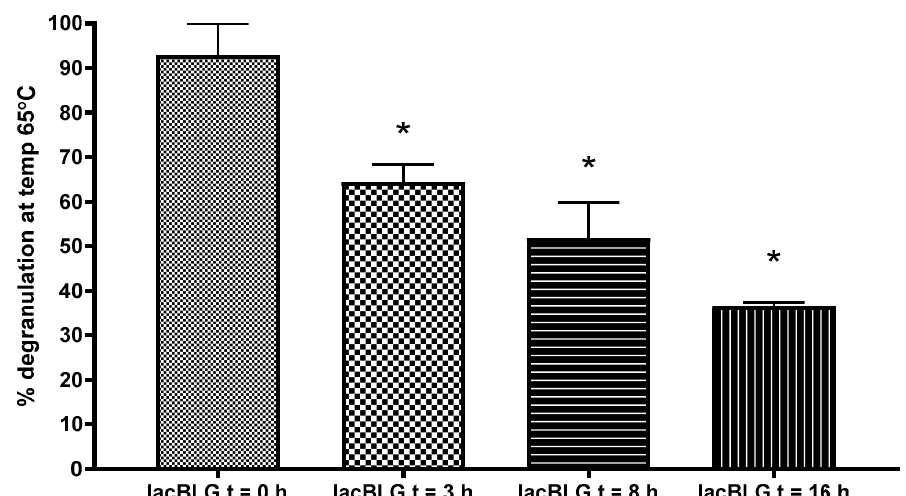
Figure 7. Human FceRI a chain expressing RBL cells incubated with a pool of chimeric huIgE anti-BLG antibodies, and subsequently cross-linked with anti-hIgE antibodies, which is set as maximum (100%) degranulation (bar not shown) or lactosylated BLGWT (lacBLG) in triplicate. Degranulation (surrogate marker of IgE binding ability or allergenicity), measured by release of β -hexosaminidase, of lactosylated BLG was calculated in % of the maximum degranulation. * One-way ANOVA p = <0.0001.